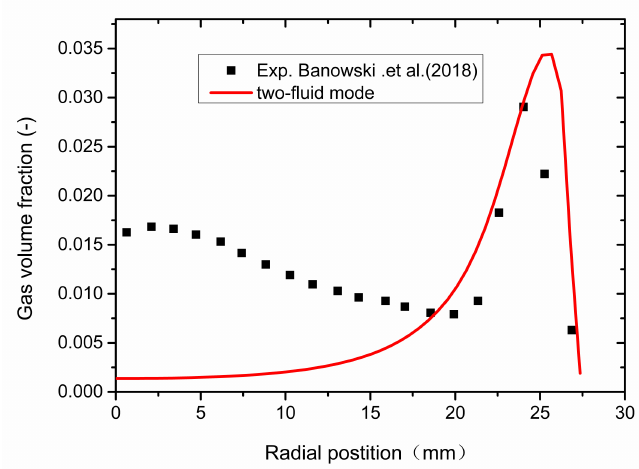
Figure 16. Calculation results of the two-fluid